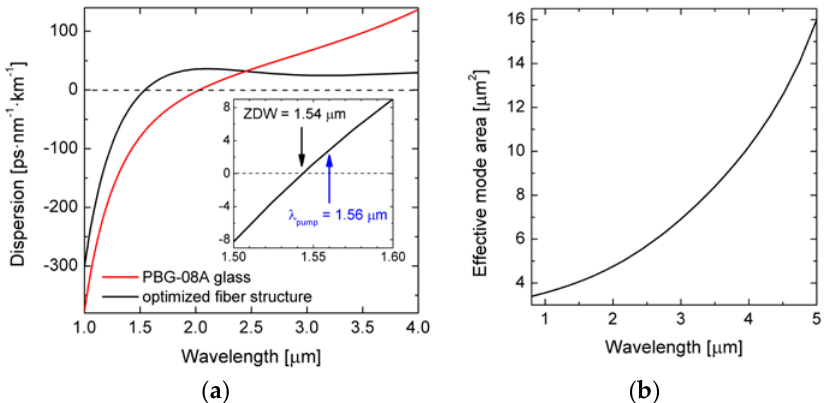
Figure 6. ( a ) Optimal dispersion characteristic and ( b ) effective mode area of the dispersion-optimized PCF.